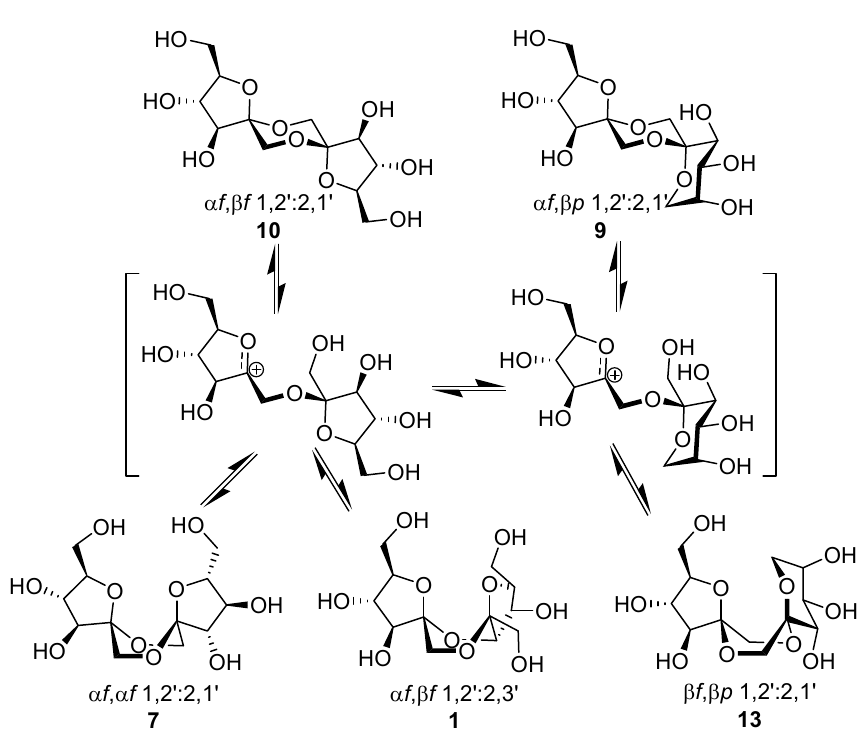
Figure 2 . DFA isomerization